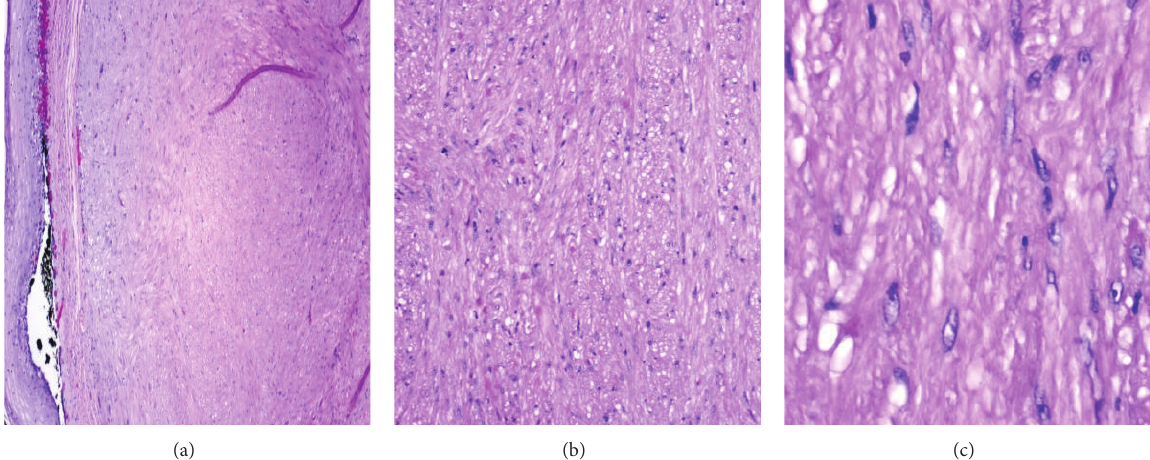
Figure 5: (a) Esophageal LM arising from muscularis mucosa. (b, c) ELM is composed of intersecting bland spindle cells with no mitosis or nuclear atypia.